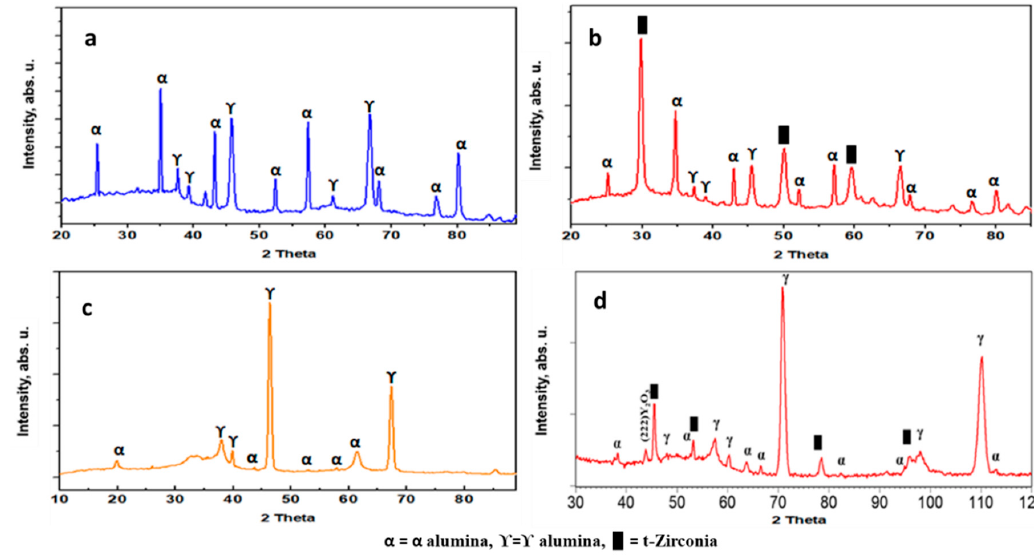
Figure 6. XRD spectra of coatings ( a ) As, ( b ) AsYs, ( c ) Ap, and ( d ) ApYs.